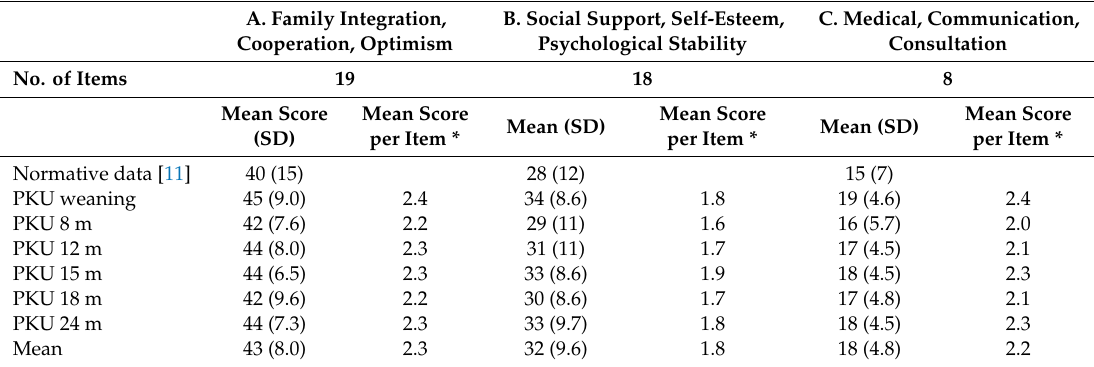
Table 1. Means and standard deviations for phenylketonuria (PKU) coping health inventory for parents (CHIP) subsets compared with normative